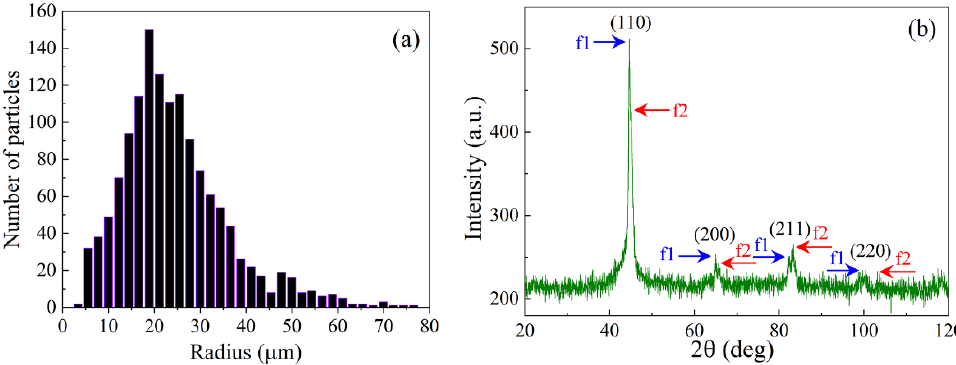
Figure 1. The distribution of flake radii ( a ); the X-ray diffraction image of the composite medium for a sample with 15% particles ( b